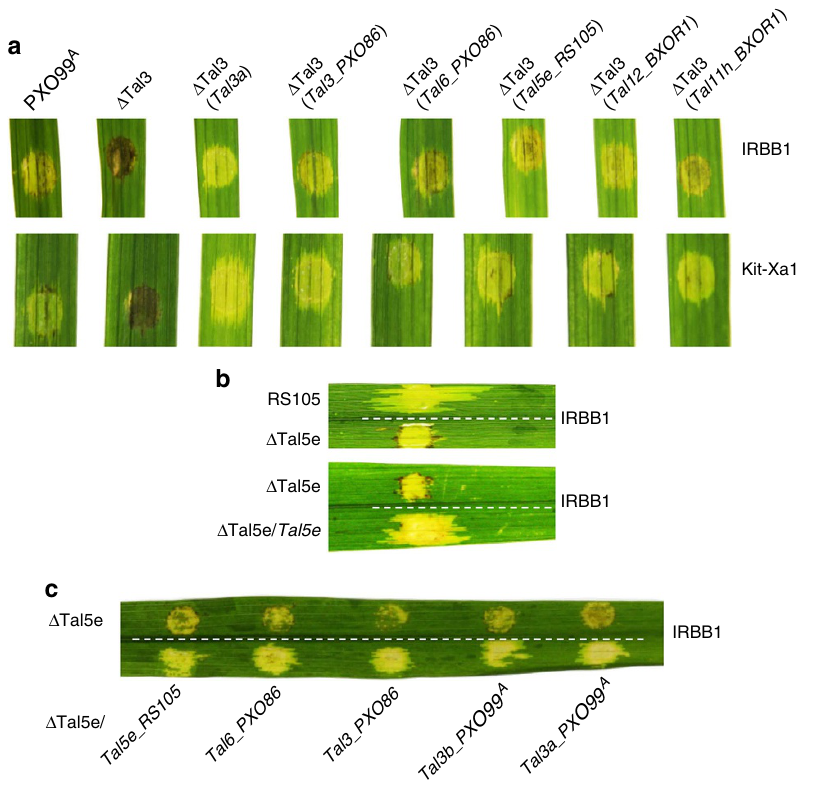
Figure 5 | Suppressive activity of iTALE genes from Xoo and Xoc. ( a ) iTALE genes from the Xoo PXO86, and Xoc RS105 and BXOR1 overcome Xa1 resistance triggered by D Tal3. ( b ) Inactivation of iTALE gene Tal5e enables the mutant ( D Tal5e) to trigger resistance in IRBB1. ( c ) iTALE genes from Xoo PXO86 and PXO99 A restore the Xoc mutant ( D Tal5e) ability to cause disease in IRBB1. Photos were taken at 4